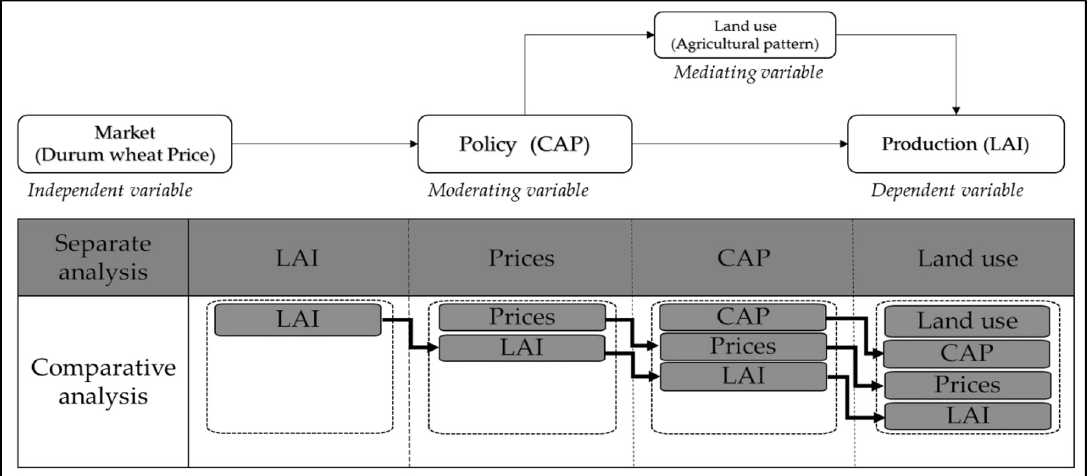
Figure 1. Methodological flowchart.